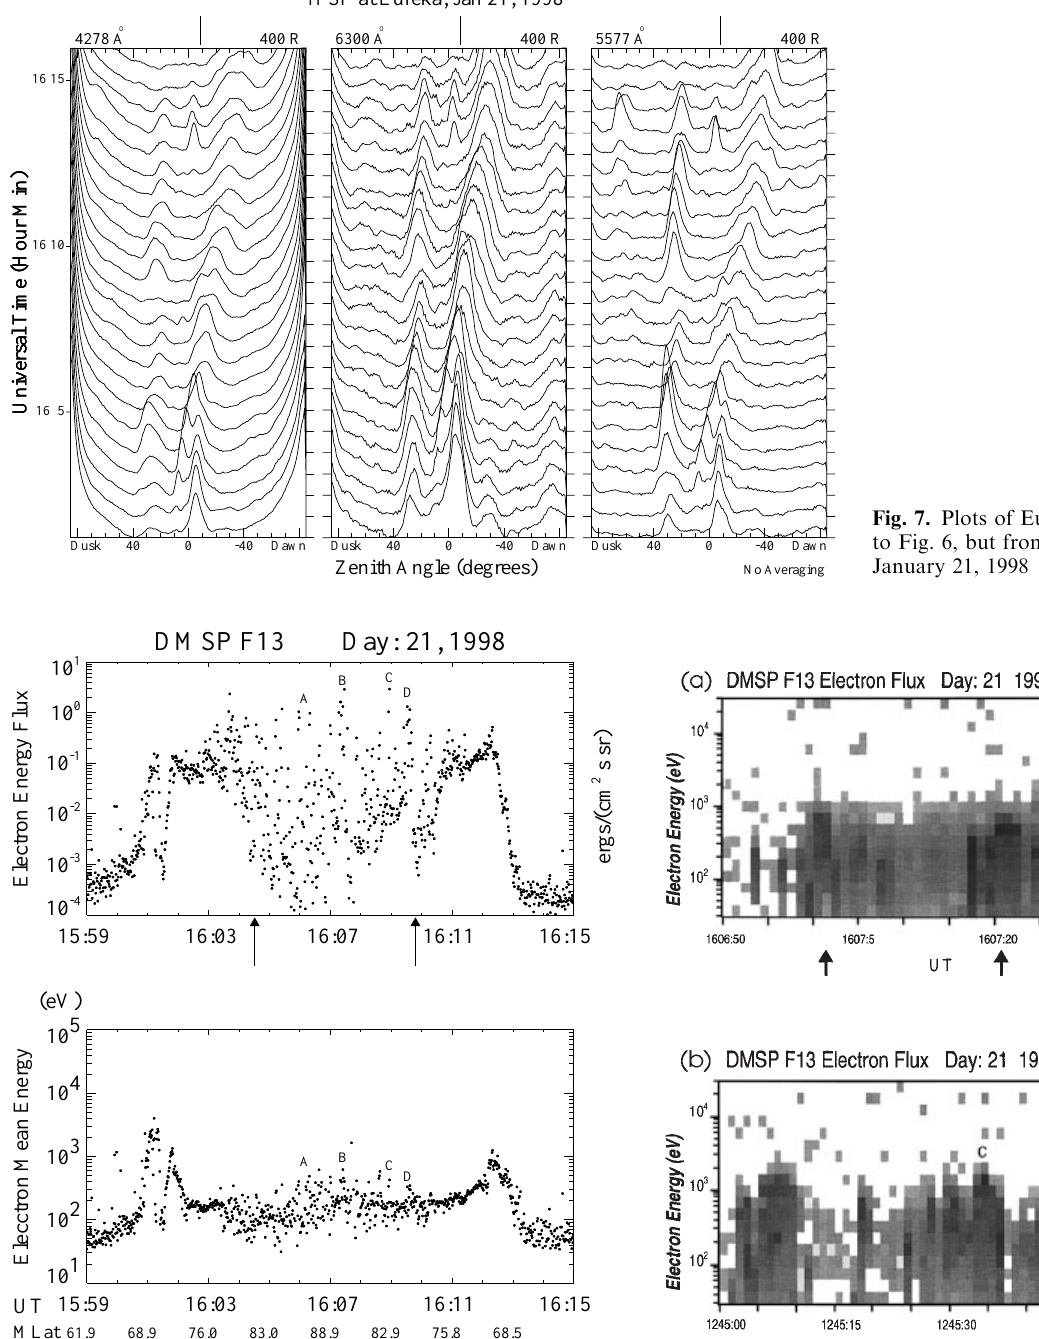
Fig. 8. DMSP F13 total electron energy flux and electron mean energy from 1559 to 1615 UT on January 21, 1998. Arrows mark the dusk and dawn boundaries of the polar cap